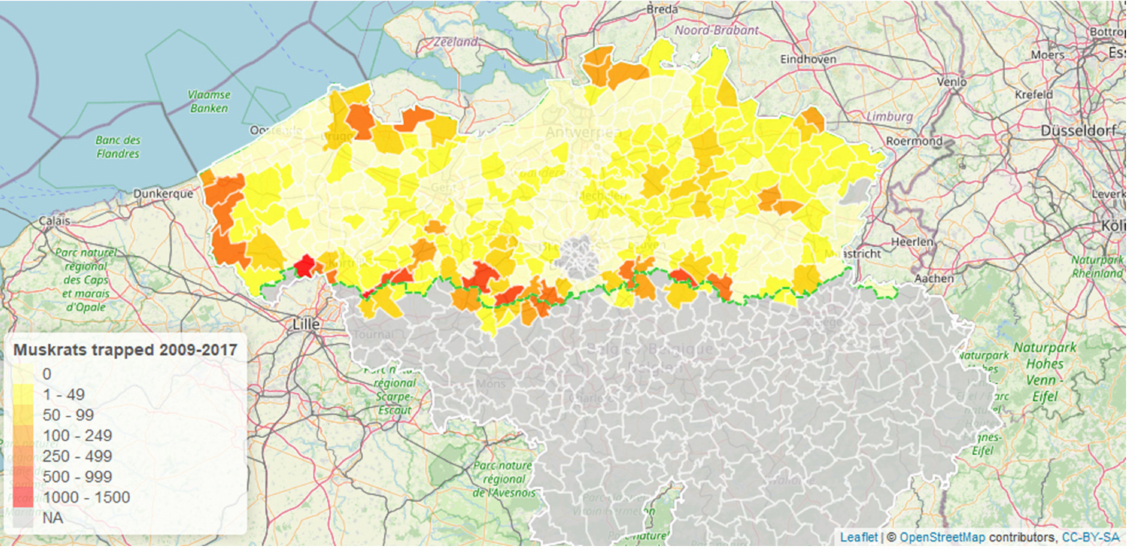
Figure 1. Number of muskrats trapped by the Flanders Environment Agency between 2009 and 2017. The regional border between Flanders and Wallonia is indicated by a green dashed